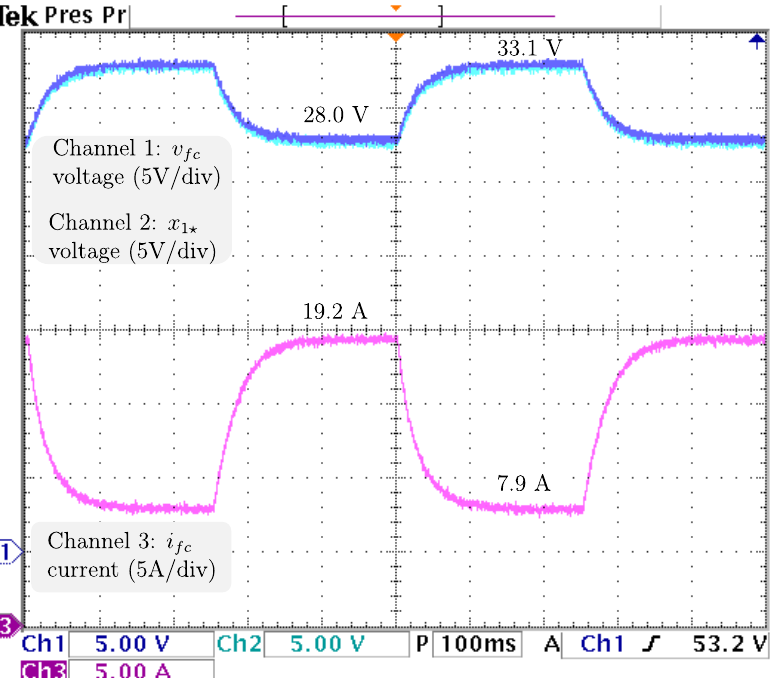
Figure 8. Real -time results for sudden load changes. From top to bottom: v fc , the fuel cell voltage; x 1 (cid:63) , the fuel cell voltage reference; and i fc , the fuel cell